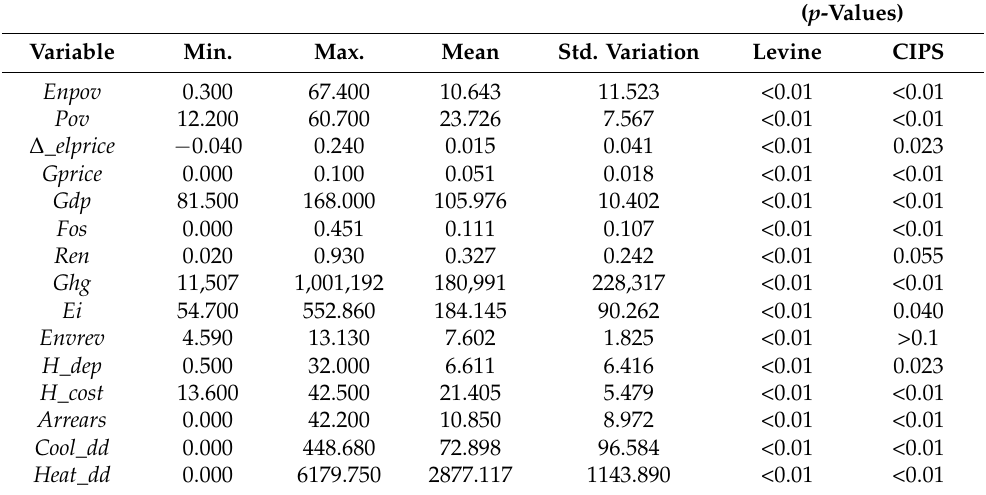
Table 2. Summary